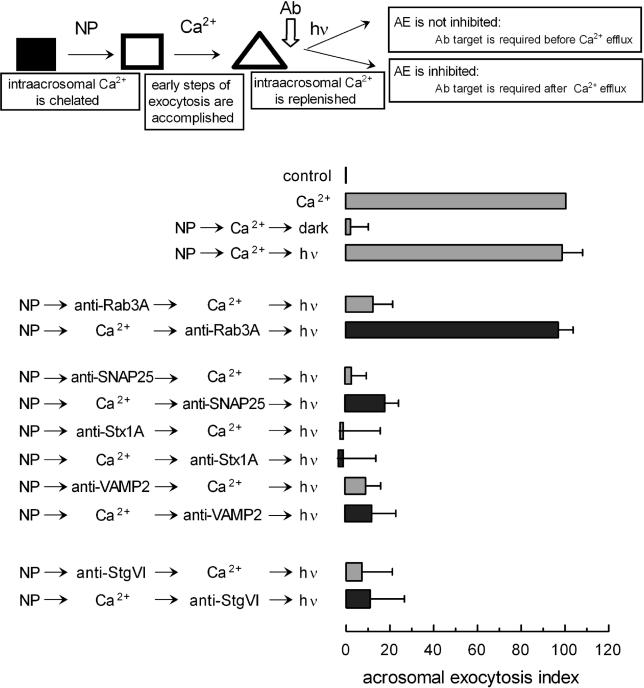
Rab3A Is Required before, and SNAREs and Synaptotagmin VI after, Intra-Acrosomal Ca2+ EffluxPermeabilized spermatozoa were loaded with 10 μM NP-EGTA-AM (NP) for 15 min at 37 °C to chelate intra-acrosomal Ca2+. AE was then initiated by adding 0.5 mM CaCl2 (10 μM free Ca2+)(Ca2+). After further 15 min incubation at 37 °C to allow exocytosis to proceed up to the intra-acrosomal Ca2+-sensitive step, sperm were treated for 15 min at 37 °C with antibodies that recognize Rab3A (20 μg/ml, anti-Rab3A), SNAP25 (20 μg/ml, anti-SNAP25), syntaxin1A (1/25 dilution, anti-Stx1A), VAMP2 (20 μg/ml, anti-VAMP2), or synaptotagmin VI (30 μg/ml, anti-StgVI). All these procedures were carried out in the dark. UV flash photolysis of the chelator was induced at the end of the incubation period (hν), and the samples were incubated for 5 min to promote exocytosis (NP→Ca2+→antibody→hν, black bars; a diagram of the experiment is shown at the top of the figure). Sperm were then fixed and AE was measured as described in Materials and Methods. Several controls were included (grey bars): background AE in the absence of any stimulation (control); AE stimulated by 10 μM free Ca2+ (Ca2+), inhibitory effect of NP-EGTA-AM in the dark (NP→Ca2+→dark), and the recovery upon illumination (NP→Ca2+→hν); and inhibitory effect of the antibodies when present throughout the experiment (NP→antibody→Ca2+→hν). The data were normalized as described in Materials and Methods (mean ± SEM). Statistical analysis is provided in Table S2.